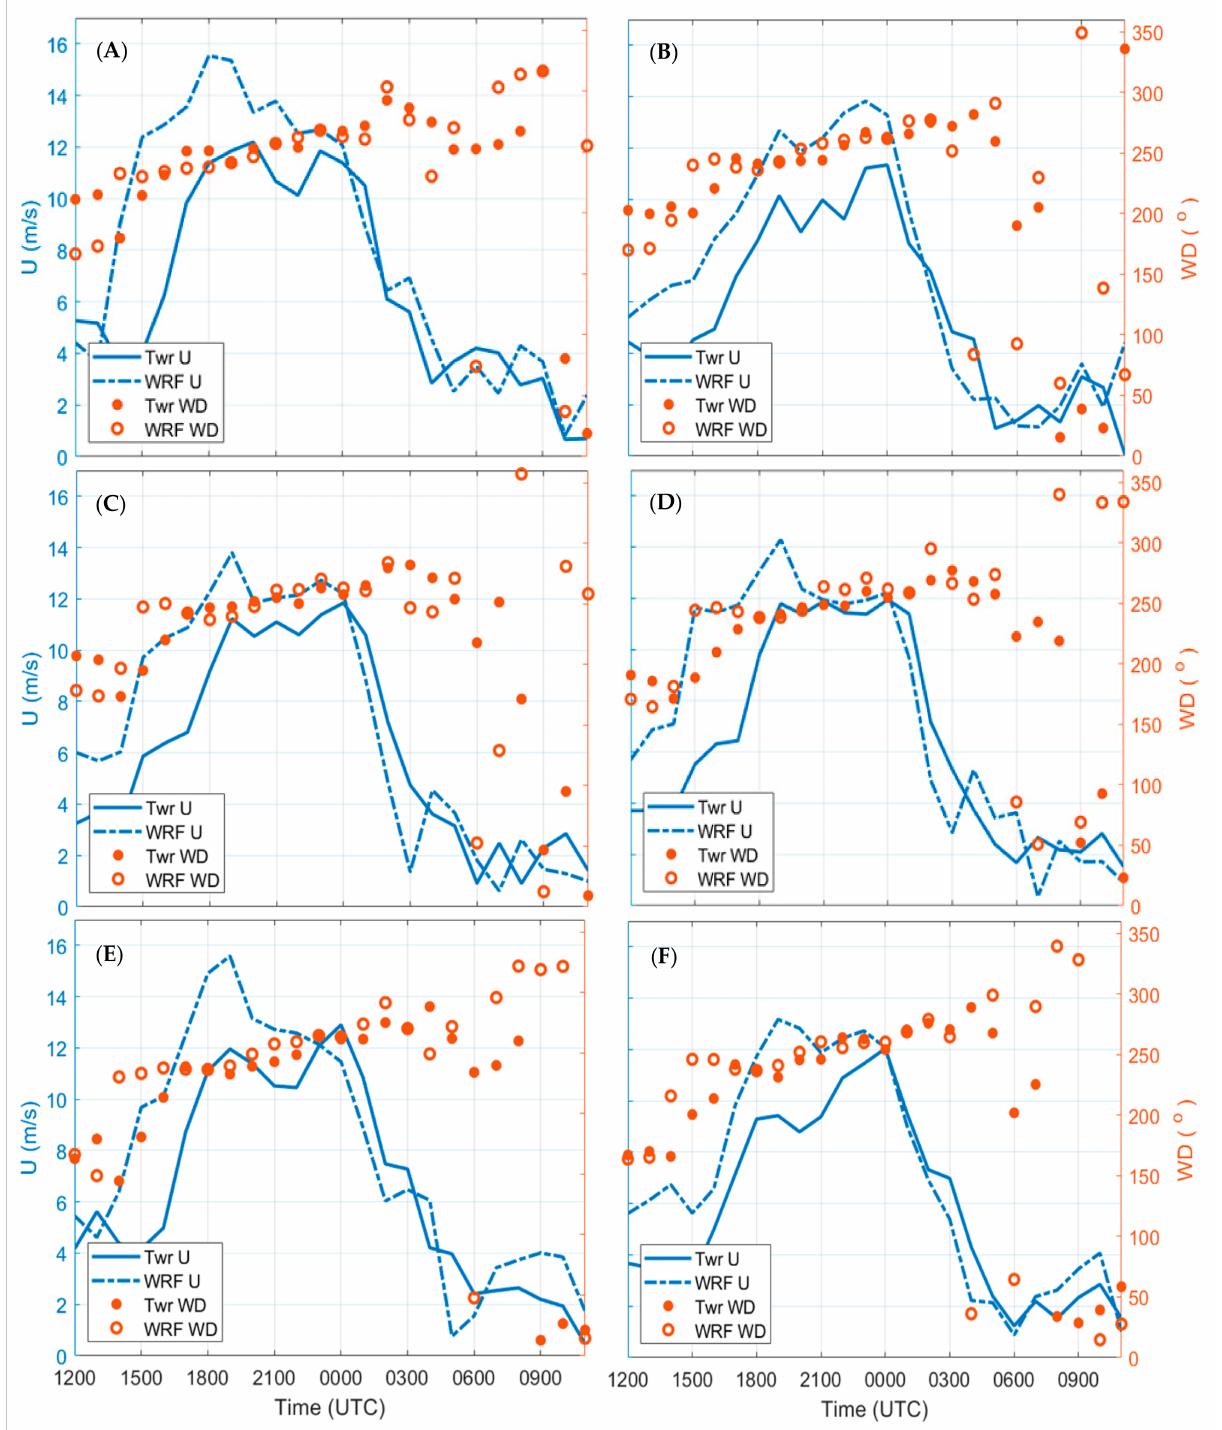
Figure 5. Time history plots comparing WRF U and wind direction ( WD ) to MSA tower measurements on 17 April 2018. ( A ) Tower 11, ( B ) Tower 13, ( C ) Tower 18, ( D ) Tower 20, ( E ) Tower 23, and ( F ) Tower